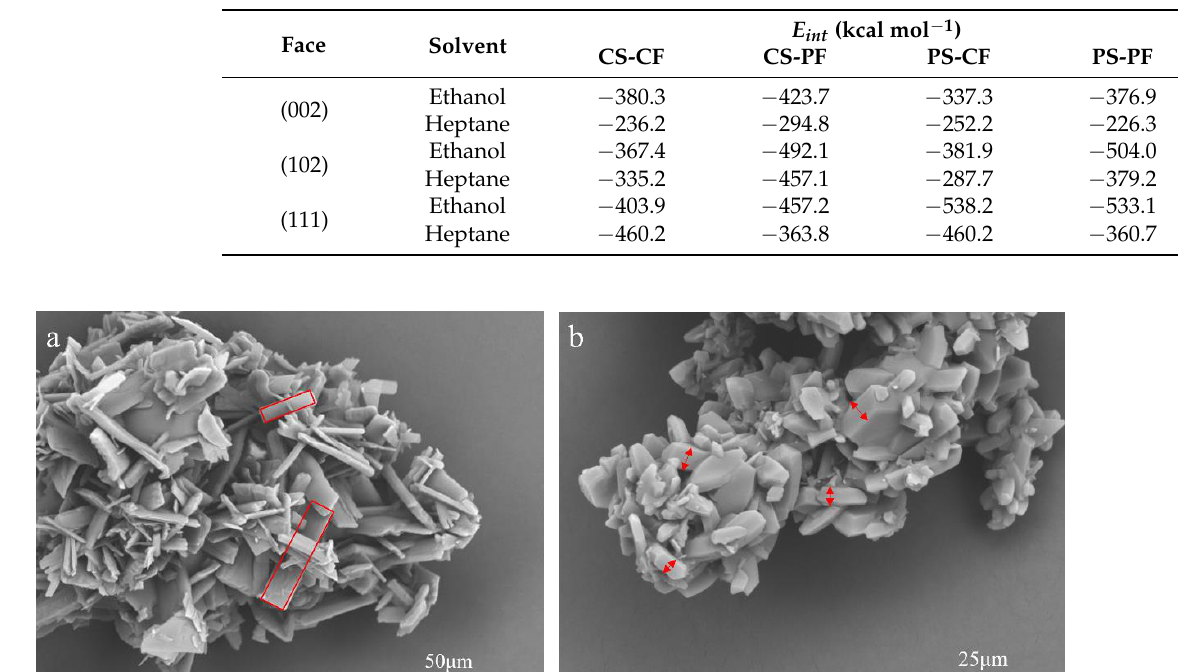
Table 2. The E int (kcal mol − 1 ) between the crystal layer and solution layer of the (002), (102), and (111) crystal faces from different models.